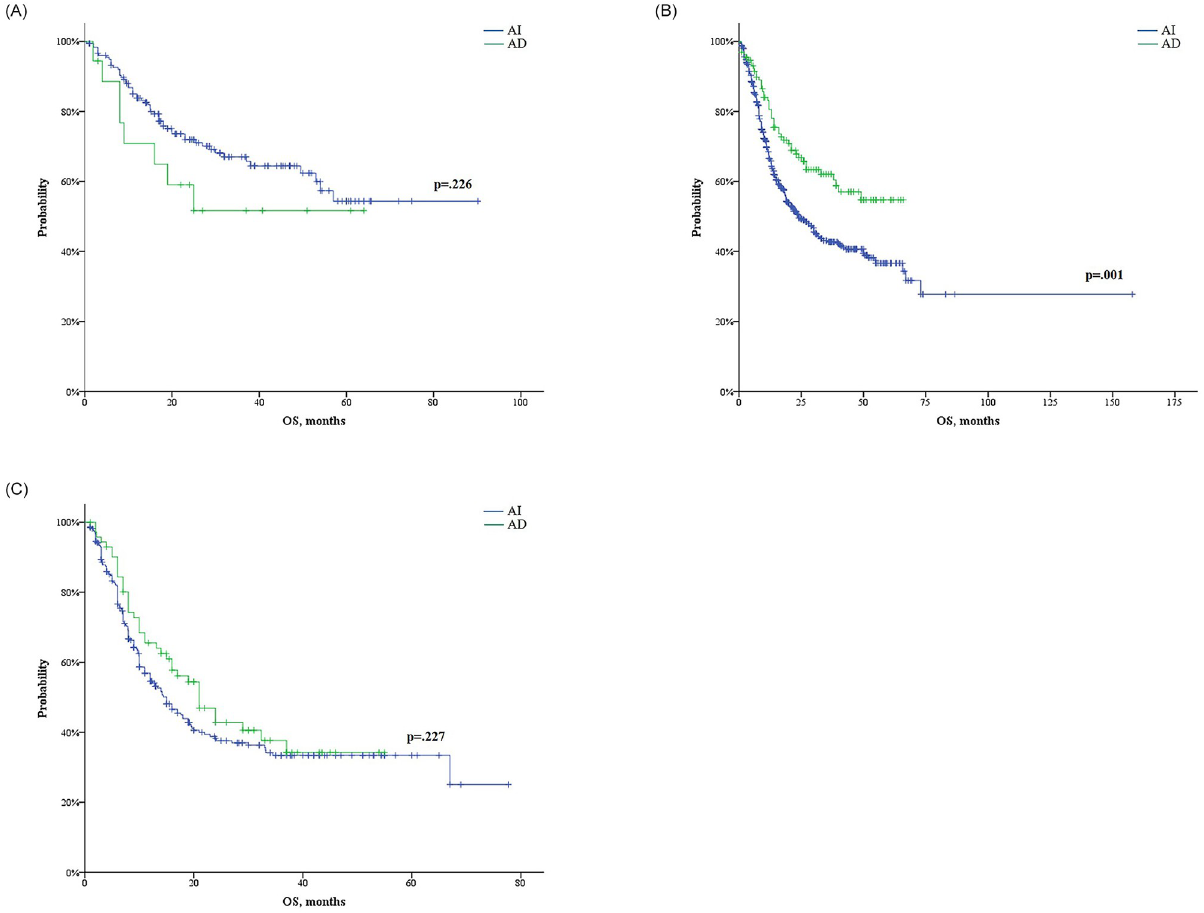
Fig 6. Overall survival (OS) comparison of cytarabine plus idarubicin and cytarabine plus daunorubicin (AD) by cytogenetic risk: Favorable risk (A), intermediate risk (B), and poor risk (C).